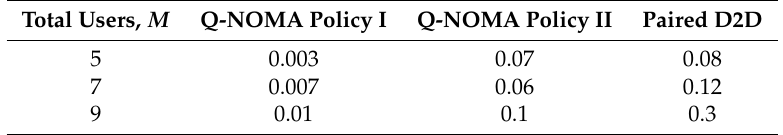
Table 4. Average outage comparison between paired device-to-device (D2D) and quality of